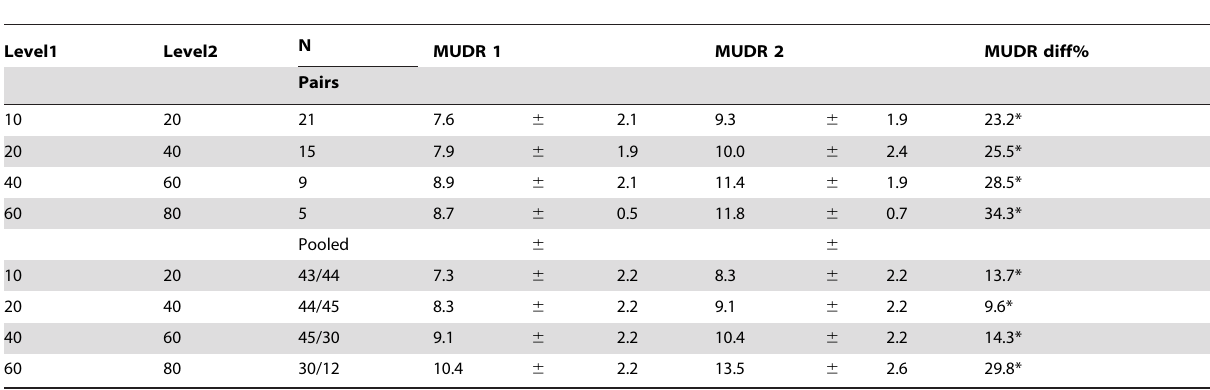
Table 2. The difference in motor unit discharge rate (MUDR) between force levels in motor unit pairs (top) and all pooled units (bottom) in isometric contractions.